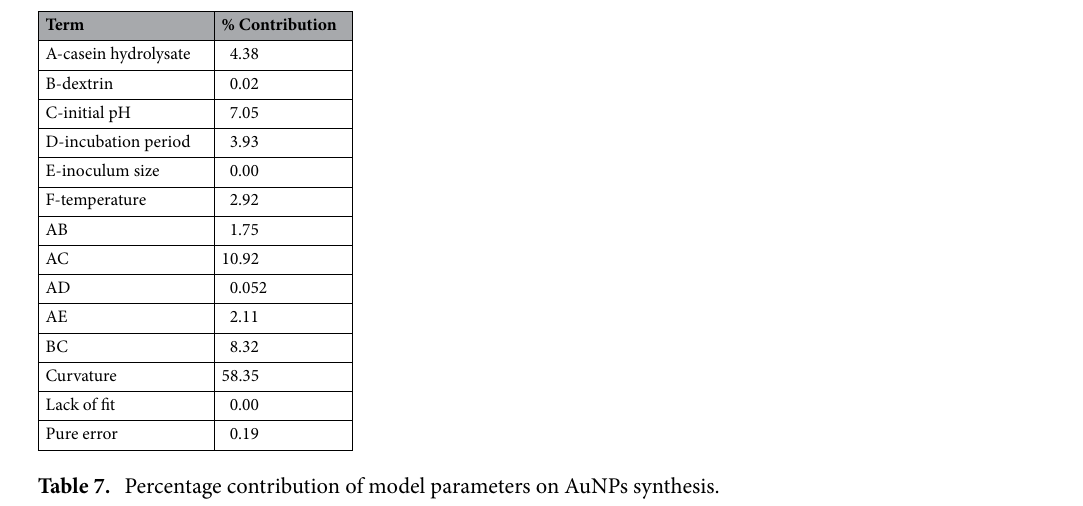
Table 7. Percentage contribution of model parameters on AuNPs